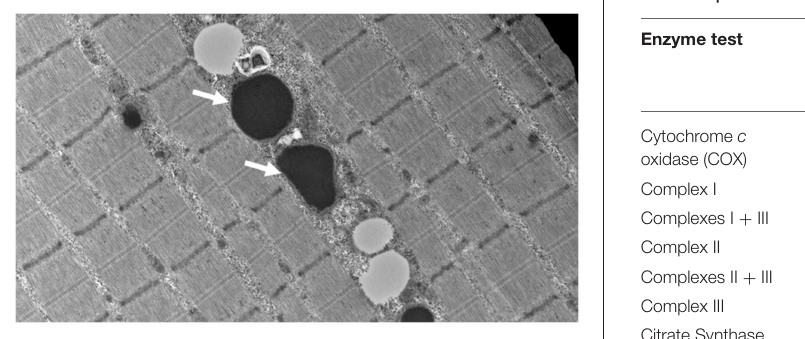
TABLE 1 | Mitochondrial enzyme activity from